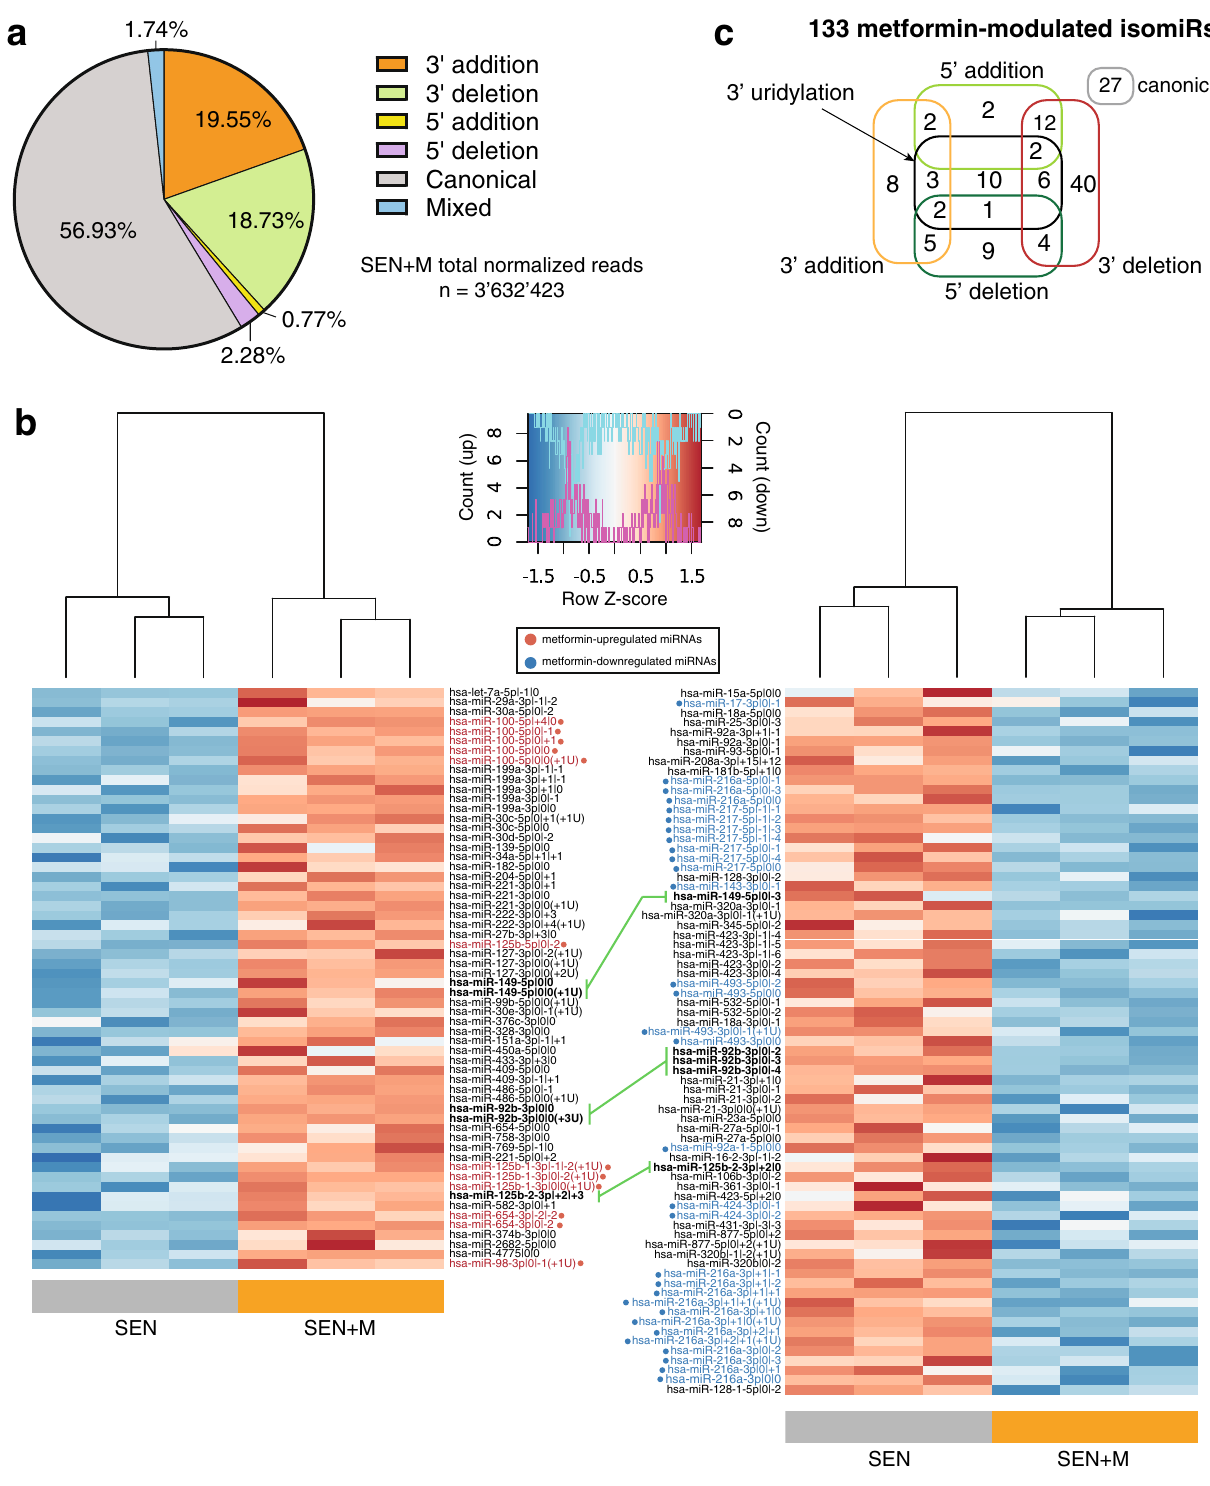
Figure 3. IsomiR analysis of senescent HUVECs treated with metformin. ( a ) Pie chart showing the proportion of isomiR variations in SEN + M samples. ( b ) Heatmaps showing clustering of samples, and isomiRs upregulated (left panel) and downregulated (right panel) in SEN + M compared to SEN, with a FC ≥ 1.5 and FDR < 0.05 cut-off. Data is shown following Z-score transformation. Red color indicates Z-scores > 0 (above mean), blue color indicates Z-scores < 0 (below mean). IsomiR labels are marked and colored in red or blue according to the upregulation or downregulation of their parent miRNA in SEN + M, respectively. Green lines connect variations of the same miRNA (labeled in bold) showing opposite modulation between SEN + M and SEN. IsomiRs are ordered by the MIMAT ID of the parent miRNA. For the isomiR nomenclature, the reader is referred to the Materials and Methods section. ( c ) Diagram reporting the frequencies of the different type of variations among isomiRs modulated by metformin